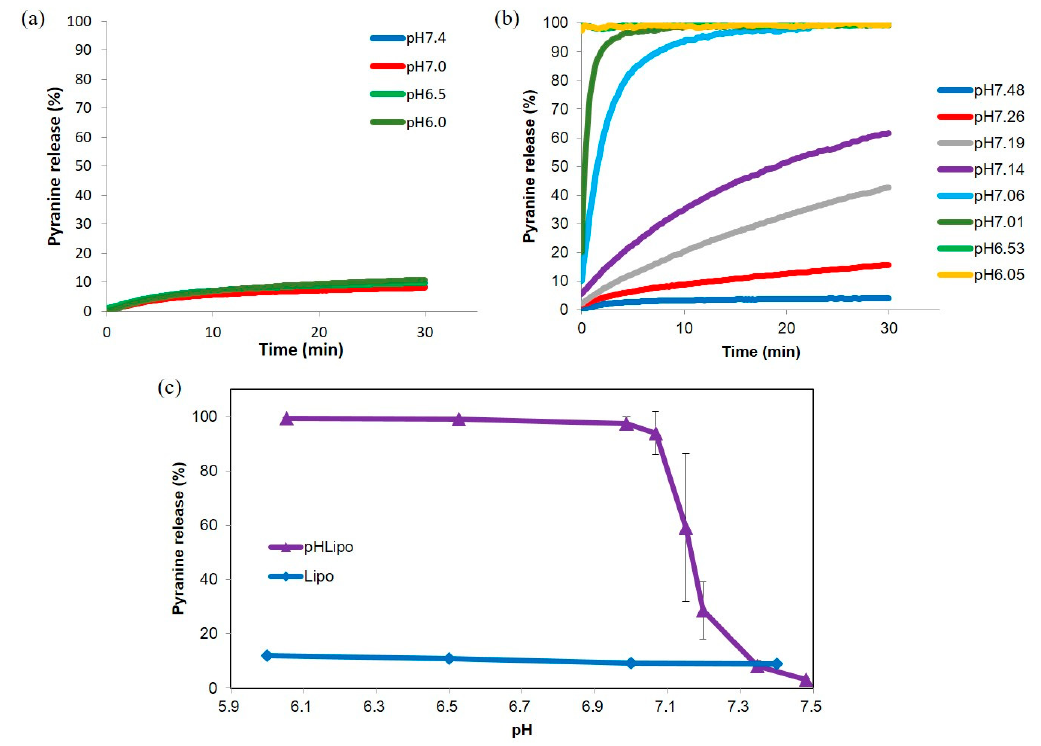
Figure 3. Typical time courses ( a , b ) and pH-dependence after 30 min incubation ( c ) of pyranine release from PEG liposomes modified with or without CHexPG-PE at 37 °C.